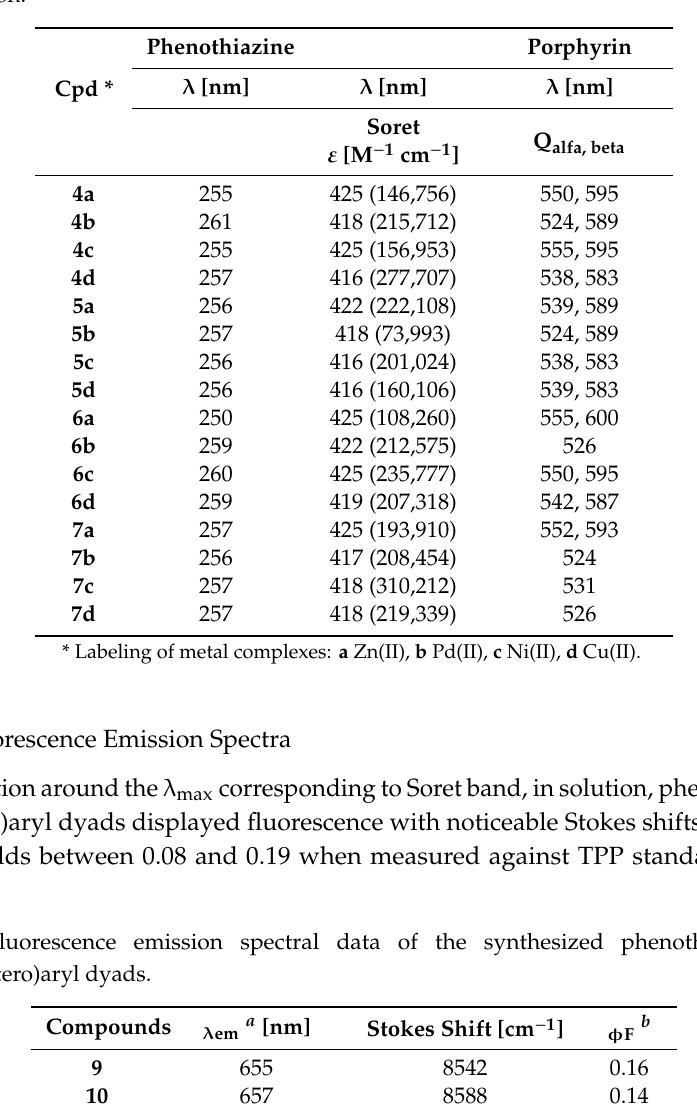
Table 2. UV–Vis linear optical properties of metal complexes of bromoMPP ( 4 , 5 ) and chloroMPP ( 6 , 7 ) in DCM solution.